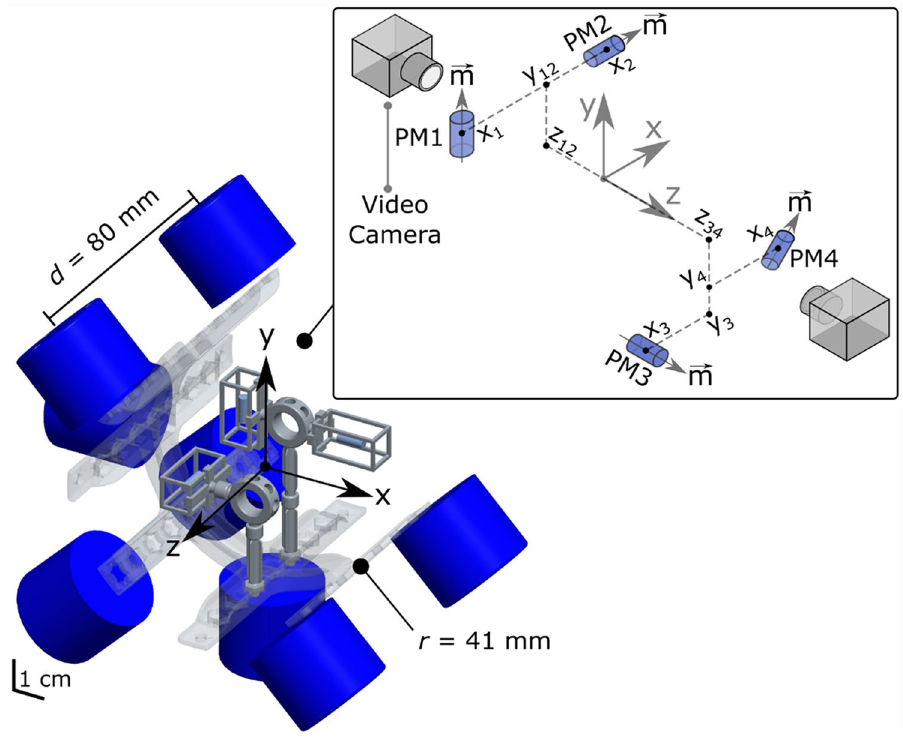
Figure 2. Prototype of the myokinetic stimulation interface and related characterization setup. The prototype (only half shown for the sake of clarity) consisted of a 3D printed non-magnetic cylindrical frame ( r = 41 mm), simulating the human forearm, and twelve coils, uniformly distributed around three parallel rings (axial distance between rings l = d/ 2 = 40 mm), were fixed on the frame outer surface so to point towards its axis. Four magnets (PM1-PM4, only three shown) were suspended inside gelatin capsules (not shown) inside the frame. Inset: spatial configuration of the magnets during the assessment. PM2, PM1 and PM3 were oriented parallel to axes x , y and z , respectively. PM4 was rotated by 45° in the xy plane. During the tests, a camera was placed in one of the two indicated positions, depending on the PM being